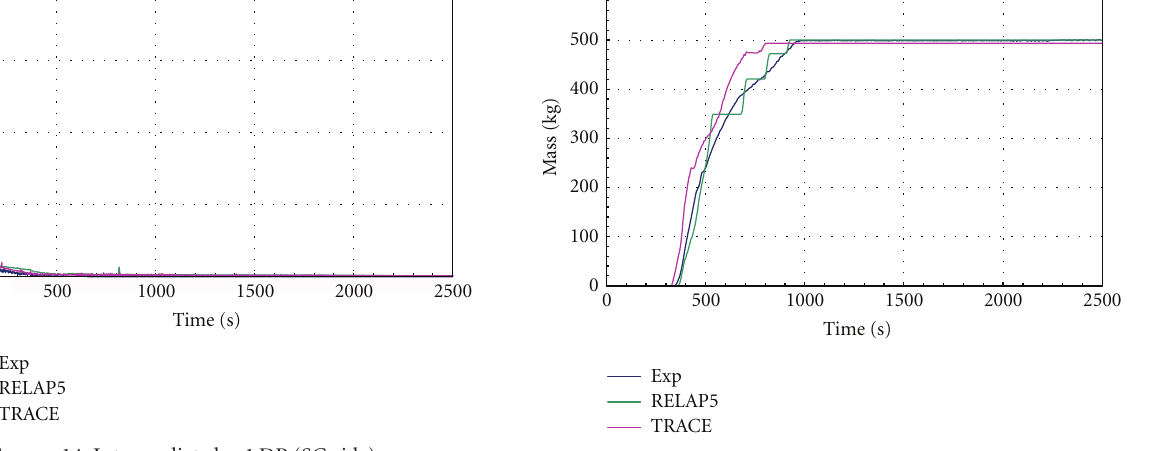
Figure 17: Integrated accumulators injected